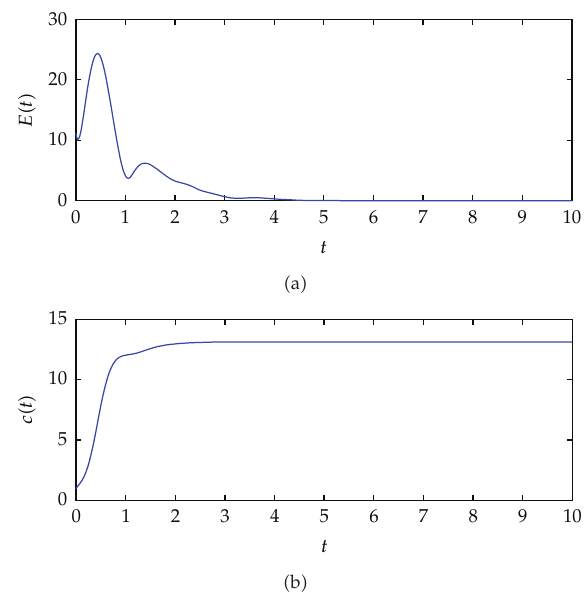
Figure 8: Adaptive adjustment of the coupling strength of a pinned Hopfield neural